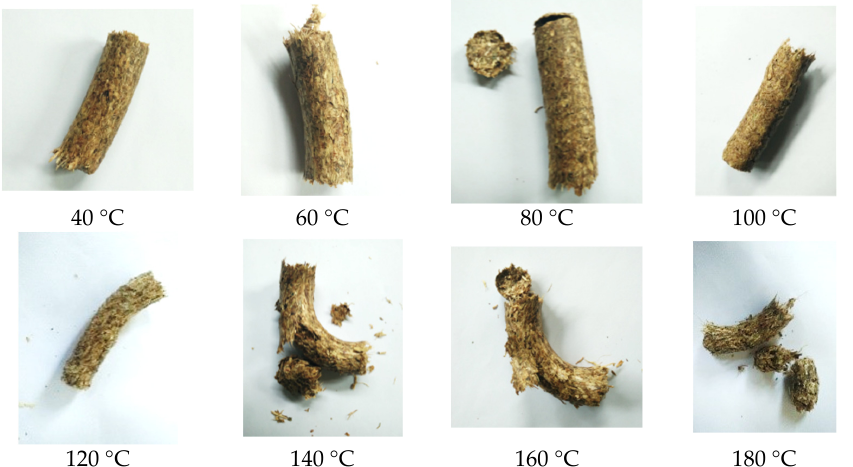
Figure 6. The surface quality of the pellets at different temperatures.